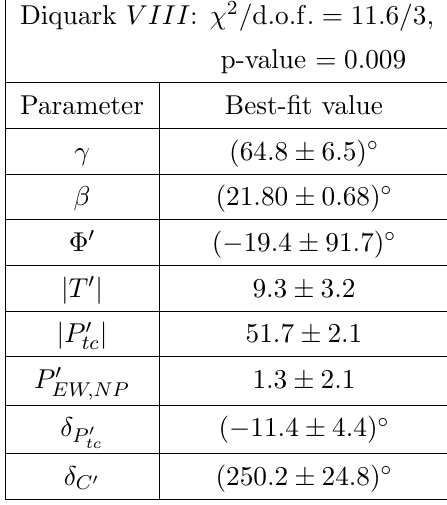
Table 13 . (cid:31) 2 = d : o : f : and best-(cid:12)t values of unknown parameters for the model of diquark V III . min Constraints: B ! (cid:25)K data, measurements of (cid:12) and (cid:13) , j C 0 =T 0 j = 0 :